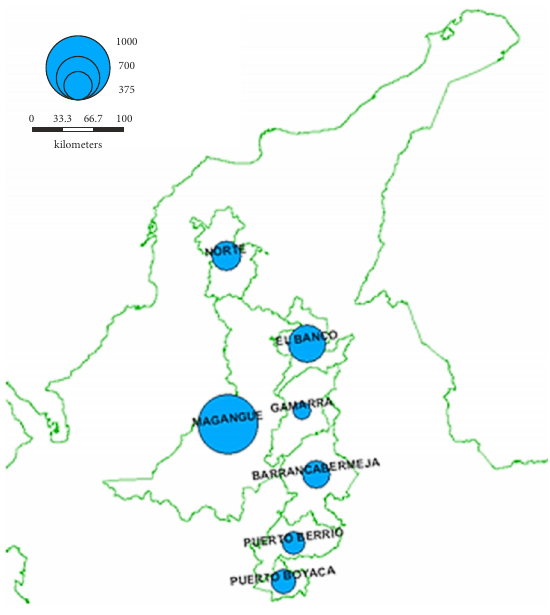
Figure 4. Generated trips by macro-zone